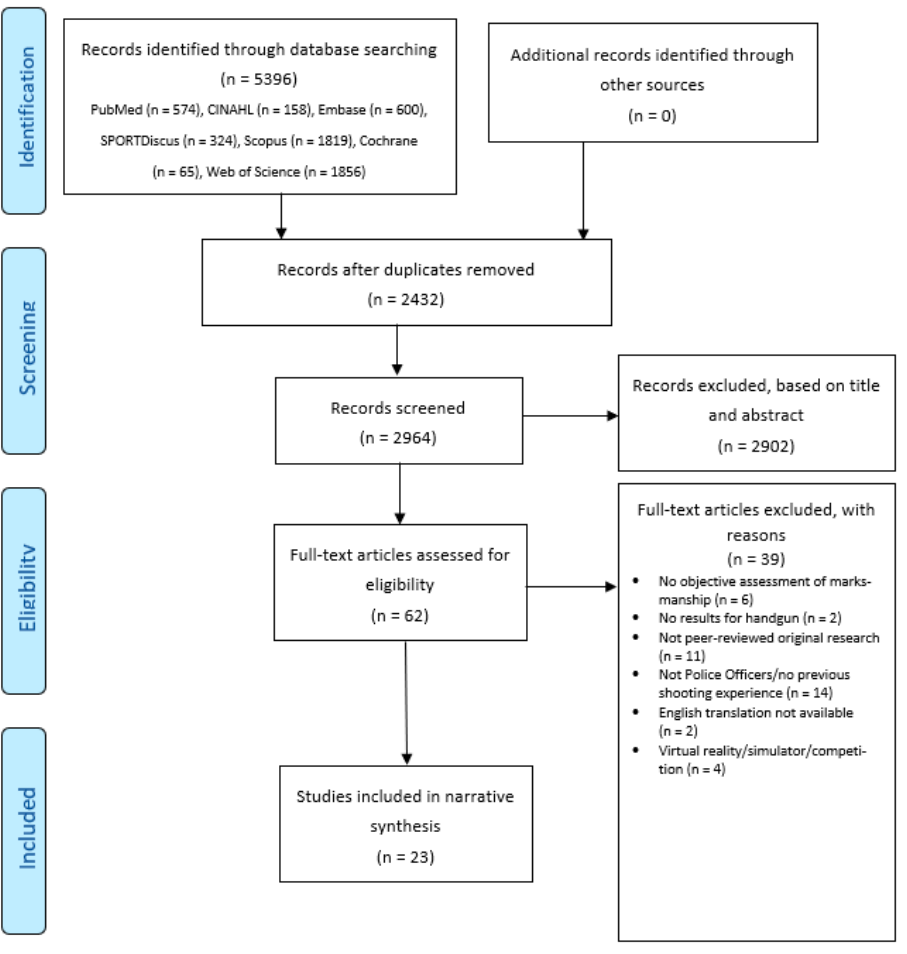
Figure 1. PRISMA flow chart diagram outlining the results of the search, screening, and selection process.